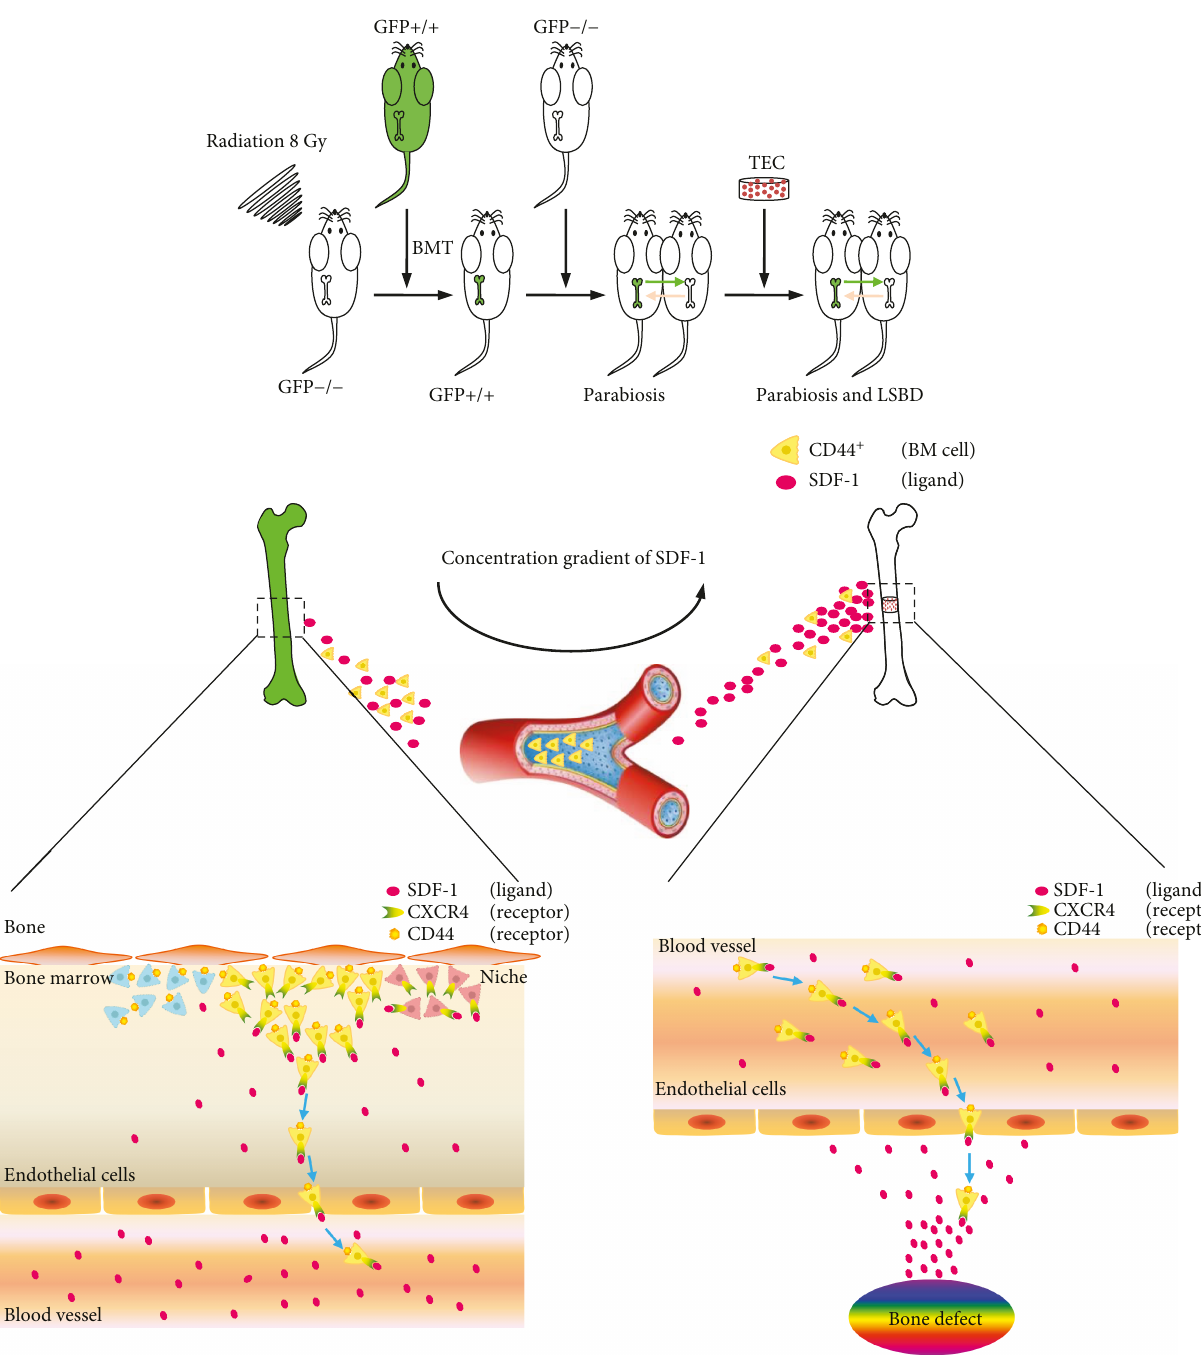
Figure 2: The schematic diagram of the whole